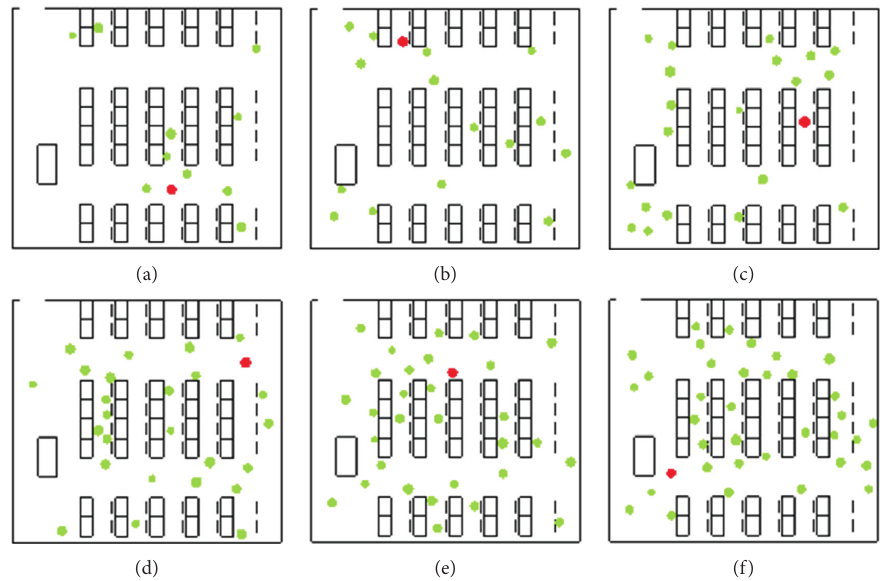
Figure 6: The initial numbers of the crowd for disorderly gathering modes. (a) 10p. (b) 15p. (c) 20p. (d) 25p. (e) 30p. (f) 35p.